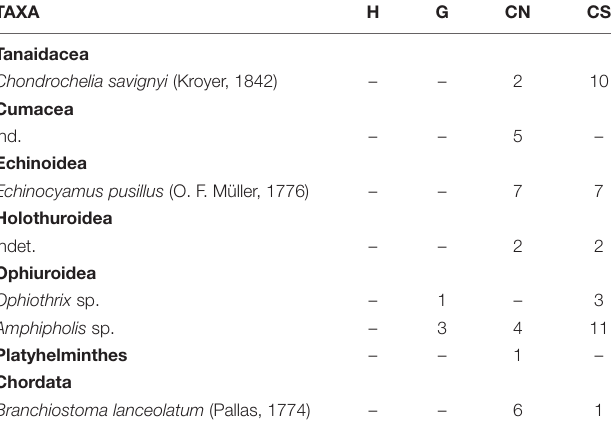
Figure 5F ), while only 2 species, the decapod Pagurus sp. only 1